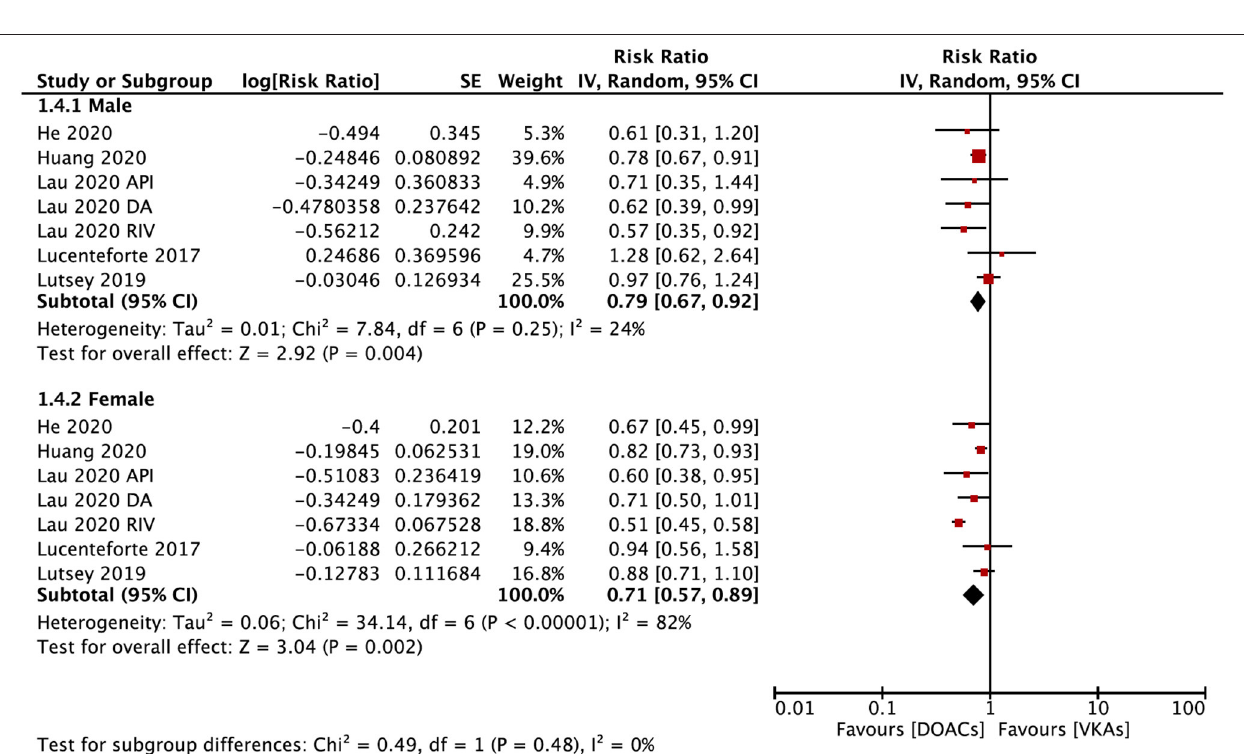
FIGURE 4 | Subgroup analysis based on sex regarding the risk of fractures of DOACs vs. VKAs in AF patients. AF, atrial fibrillation; DOACs, direct oral anticoagulants; VKAs, vitamin K antagonists; DA, dabigatran; RIV, rivaroxaban; API, apixaban; CI, confidence interval; SE, standard error; IV, inverse of the variance.